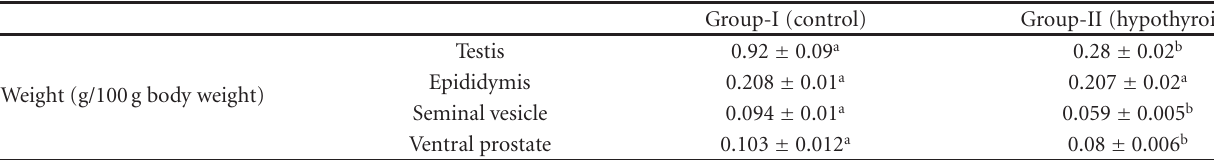
Table 2: E ff ect of neonatal PTU treatment on testis and accessory sex organs (g/100g body weight). Data are expressed as mean ± S.D. of 5 observations and subjected to unpaired Student’s t -test. Statistical significance was accepted at P < 0 . 05. Control and hypothyroid groups were found to di ff er significantly at P < 0 . 05 as represented by superscripts of di ff erent letters. Group-I (control): 30 day old control rats; Group-II (hypothyroid): 30-day-old rats with PTU treatment from day 1 postpartum to day 30